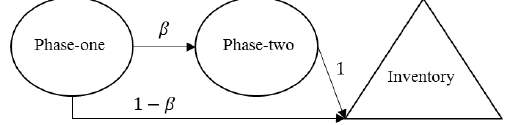
Figure 1. Representation of a Cox-2 production